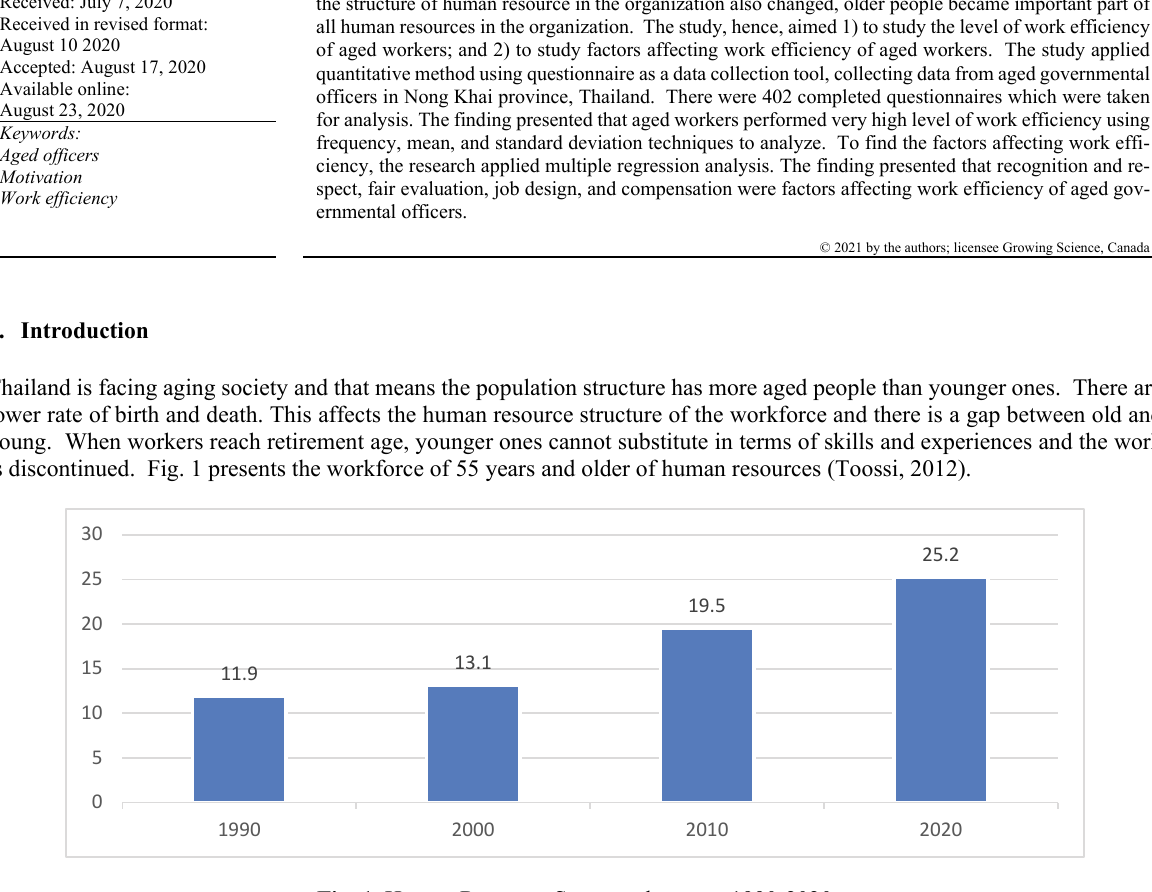
Fig. 1. Human Resource Structure between